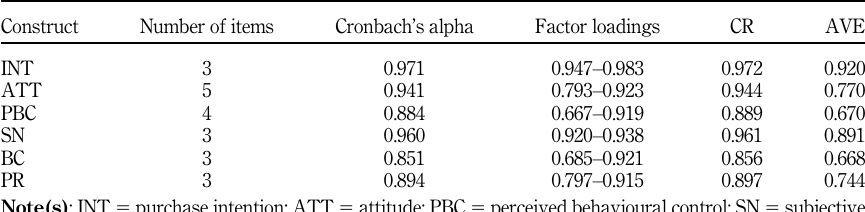
Table 2. Summary results of measurement